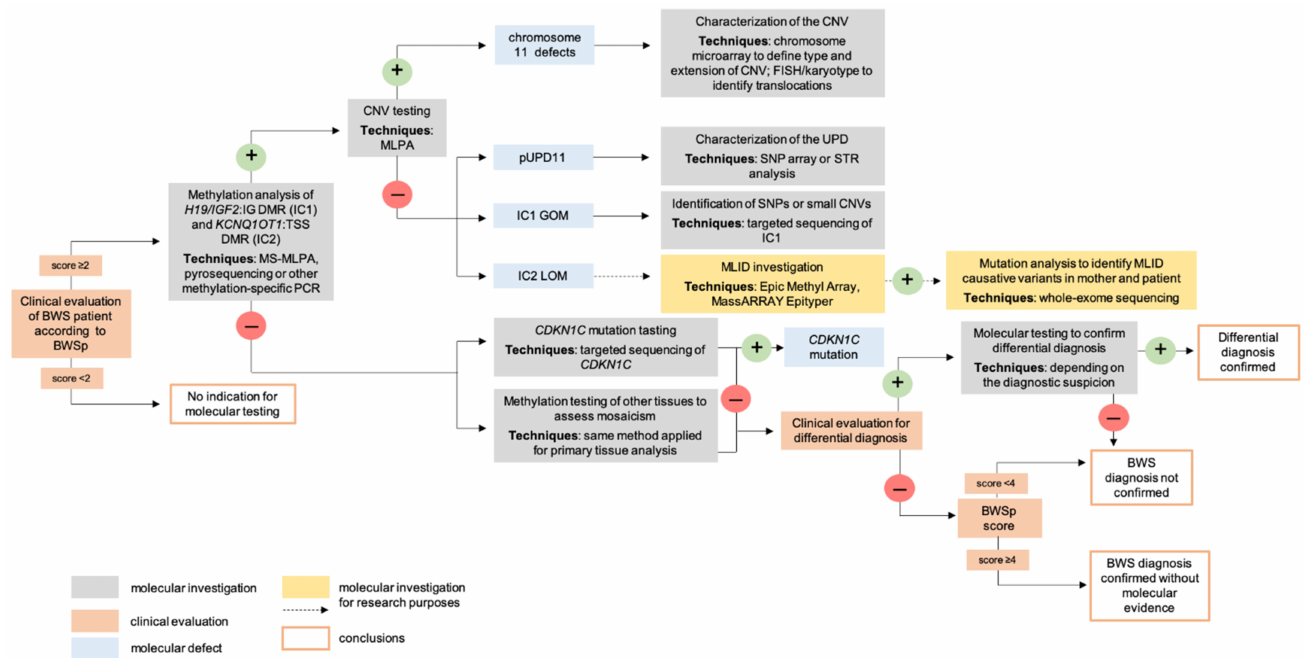
Figure 2. Diagnostic flowchart for BWS according to the BWSp scoring system [51]. Only patients with a diagnostic score ≥ 2 should receive molecular testing. Molecular testing, reported in grey boxes, should always start with a methylation analysis of IC1 and IC2, and in case of a positive result, it should always be followed by a copy number variant (CNV) assessment. A positive result (light blue boxes) of methylation analysis may derive from a primary epimutation at ICs (IC2 LOM or IC1 GOM) or pUPD11 (both IC2 LOM and IC1 GOM). SNP array may confirm pUPD11. Patients negative at methylation evaluation and CNV testing should undergo CDKN1C mutational analysis. In patients with IC2 LOM MLID methylation analysis and whole-exome sequencing for the identification of MLID causative mutations can be performed for research purposes. Negative results at all standard BWS testing may be due to tissue mosaicism and, in these cases, the analysis of tissue samples other than blood is mandatory. Differential diagnosis should be considered and appropriate tests performed. Patients with negative results for all the analyses, but with a clinical score ≥ 4, have a clinical diagnosis of BWS without a molecular evidence (adapted from